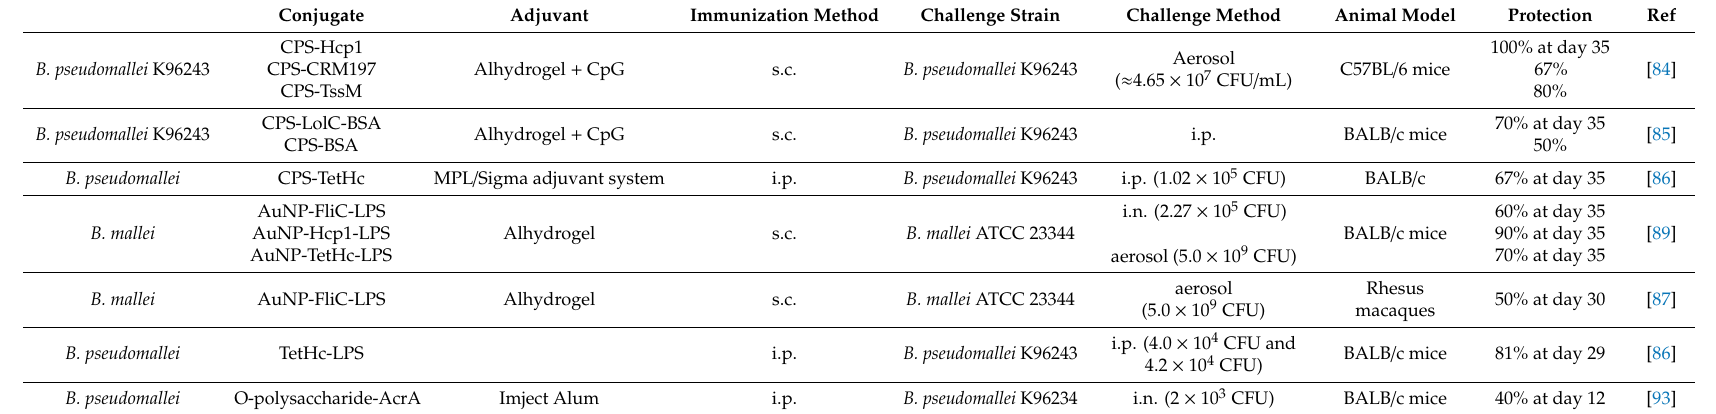
Table 4. Glycoconjugate vaccines a